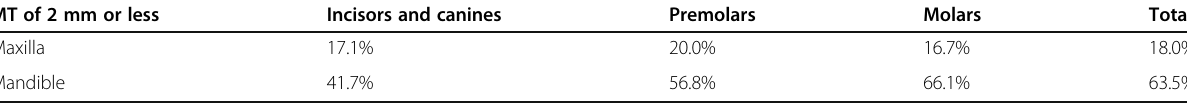
Table 2 Ratio of sites with mucosal thickness (MT) less than or equal to 2 mm MT of 2 mm or